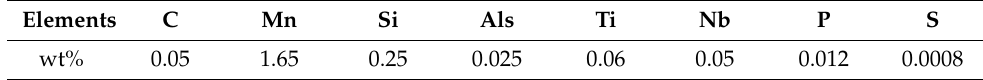
Table 1. Chemical composition of the experimental steel in wt%.